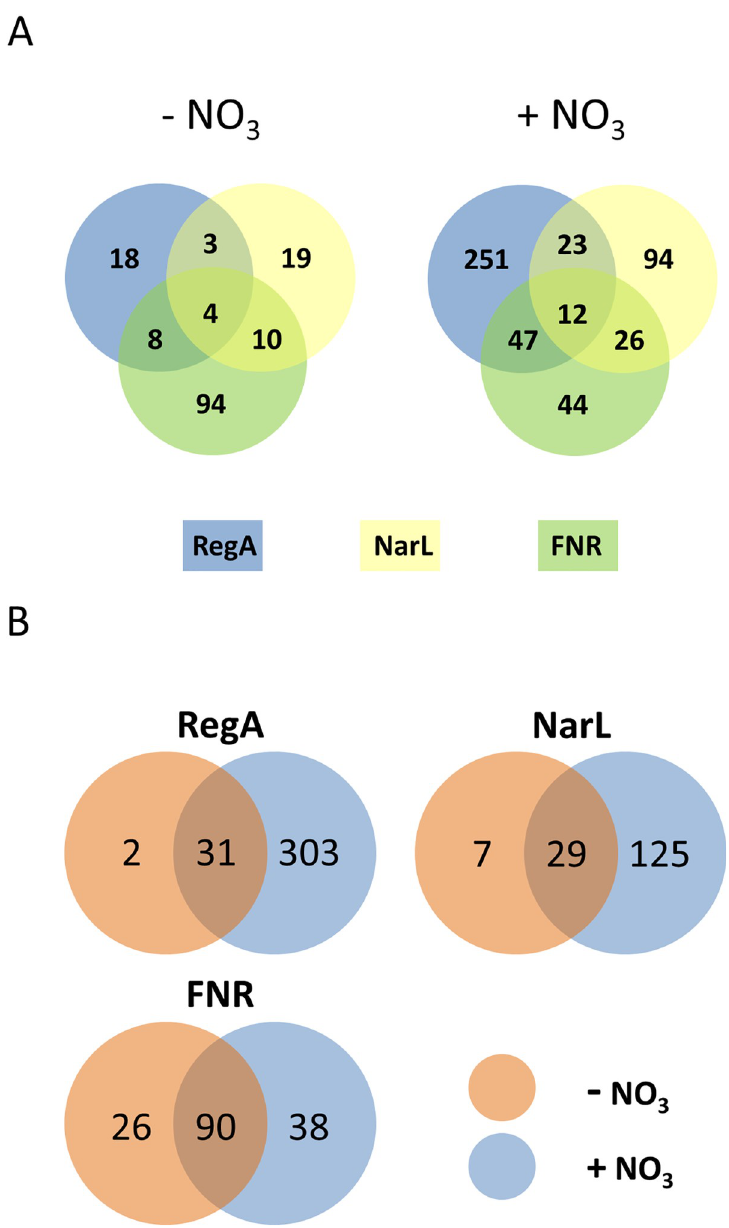
Fig 7. Influence of nitrate (NO 3- ) on the number of RegA, NarL and FNR dependent gene expressions. A: VENN Diagramm presenting the number of genes affected by the regulatory interactions between RegA, FNR and NarL obtained from global gene expression experiments. B. VENN diagrams show the total numbers of either RegA, NarL or FNR regulated genes in absence (orange) and presence (blue) of NO 3- . The overlaps represent the genes influenced under the respective regulators RegA, NarL and/or FNR and nitrate absence or presence (A) or only under both growth conditions (B).–NO 3- : growth without nitrate as TEA, + NO 3- : growth with nitrate as TEA.